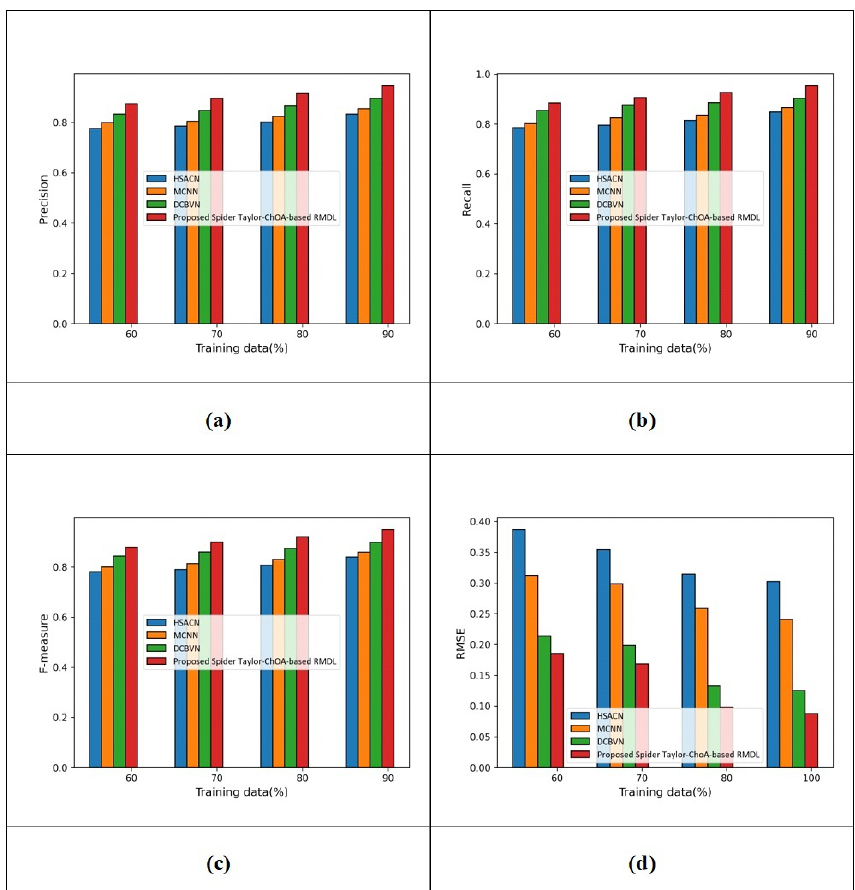
Figure 6. Results based on sentiment classification using Yelp 2014 datasets with ( a ) precision ( b ) recall ( c ) F-measure and ( d )